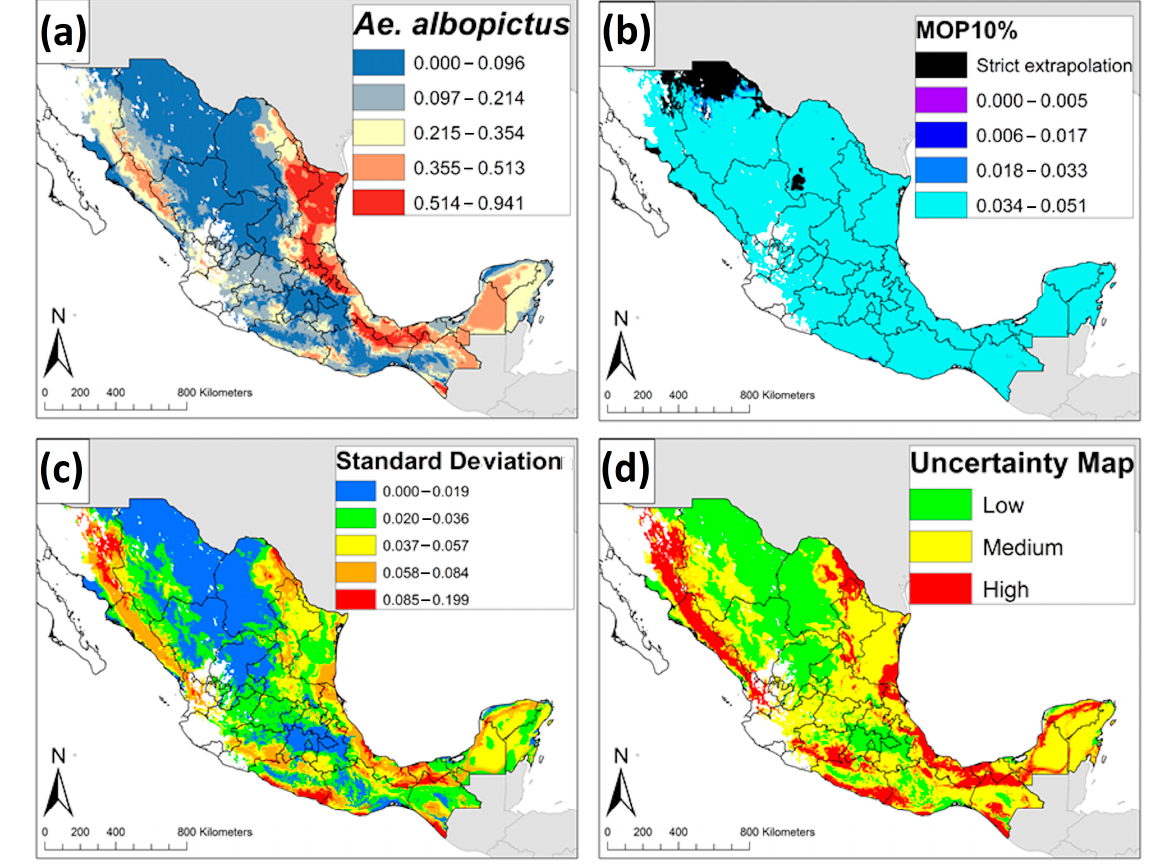
Figure 2. Ecological niche model and uncertainty maps of Aedes albopictus in México . ( a ) Ecological niche model of Aedes albopictus in México. ( b ) Extrapolation risk in projecting the model of Aedes albopictus from the calibration area to a projection area based on a mobility-oriented parity (MOP) 10%. ( c ) Standard deviation map; ( d ) Uncertainty map of Aedes albopictus prediction.